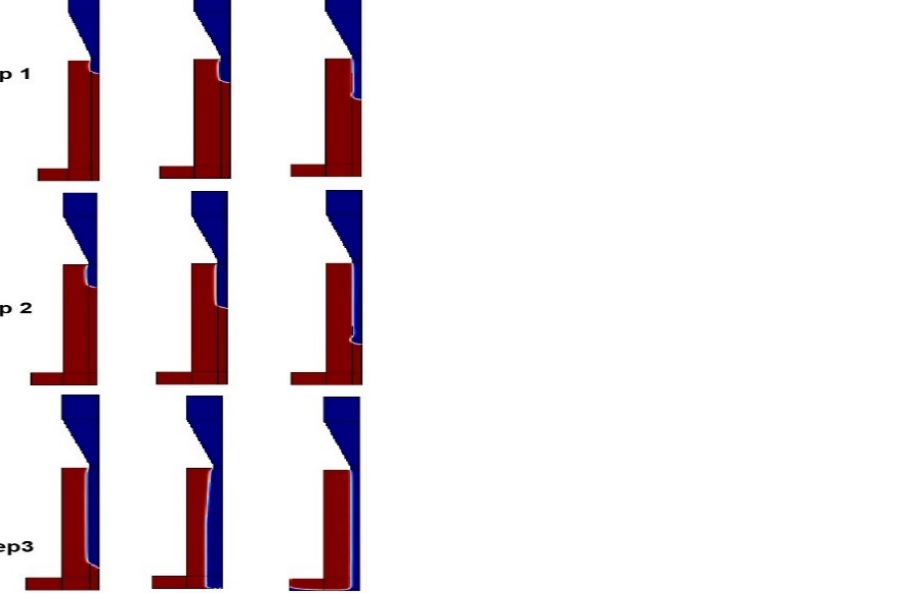
Figure 7. The extrusion formation process in extrusion 3D printing, when the velocity increases; showing process ( A ) squeezing, ( B ) dripping, and ( C ) fluid flow.